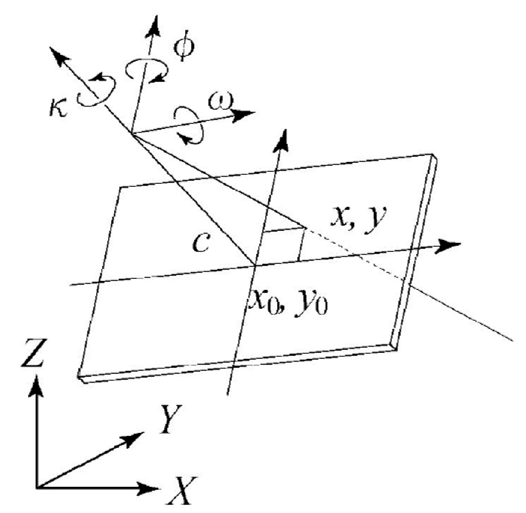
Figure 1. Schematic diagram of three different coordinate systems.